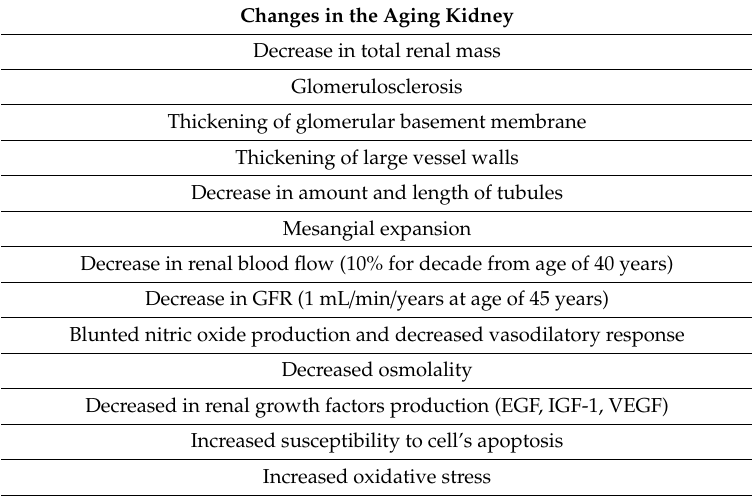
Table 2. Changes in Aging Kidney. Abbreviations: EGF, epidermal growth factor; GFR